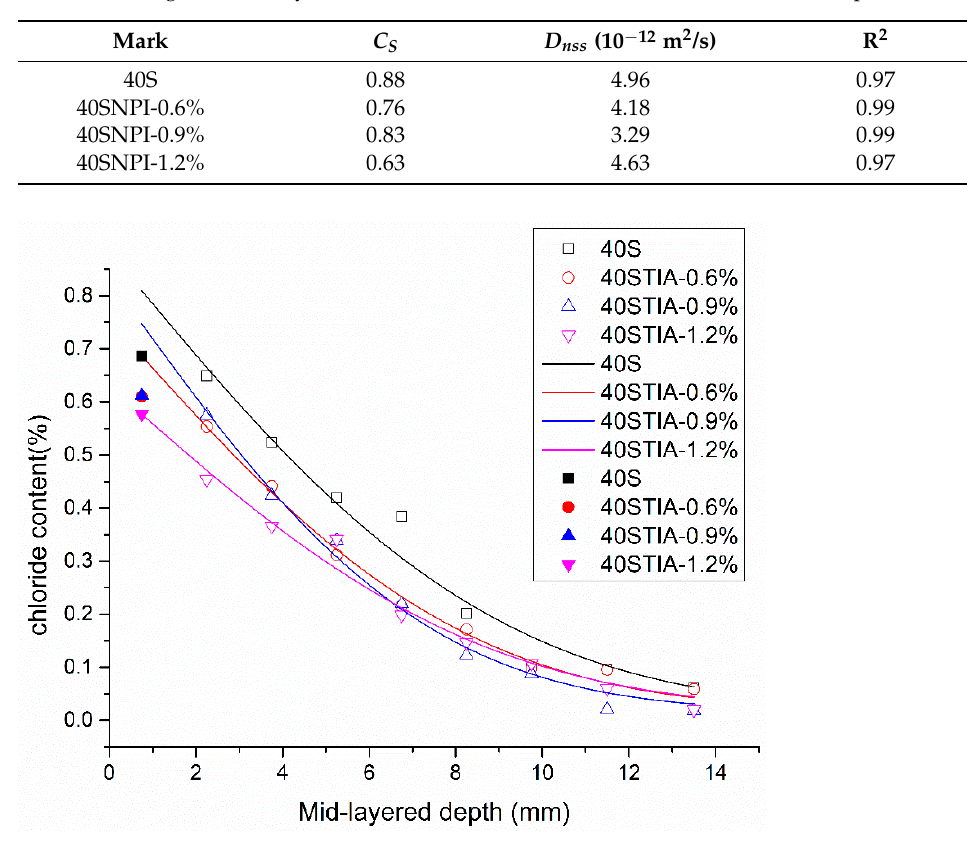
Figure 8. Chloride content and fitting curves of concrete with 0%, 0.6%, 0.9%, and 1.2% NPI, respectively. Table 3. The regression analysis results of chloride concentration in the concrete samples.